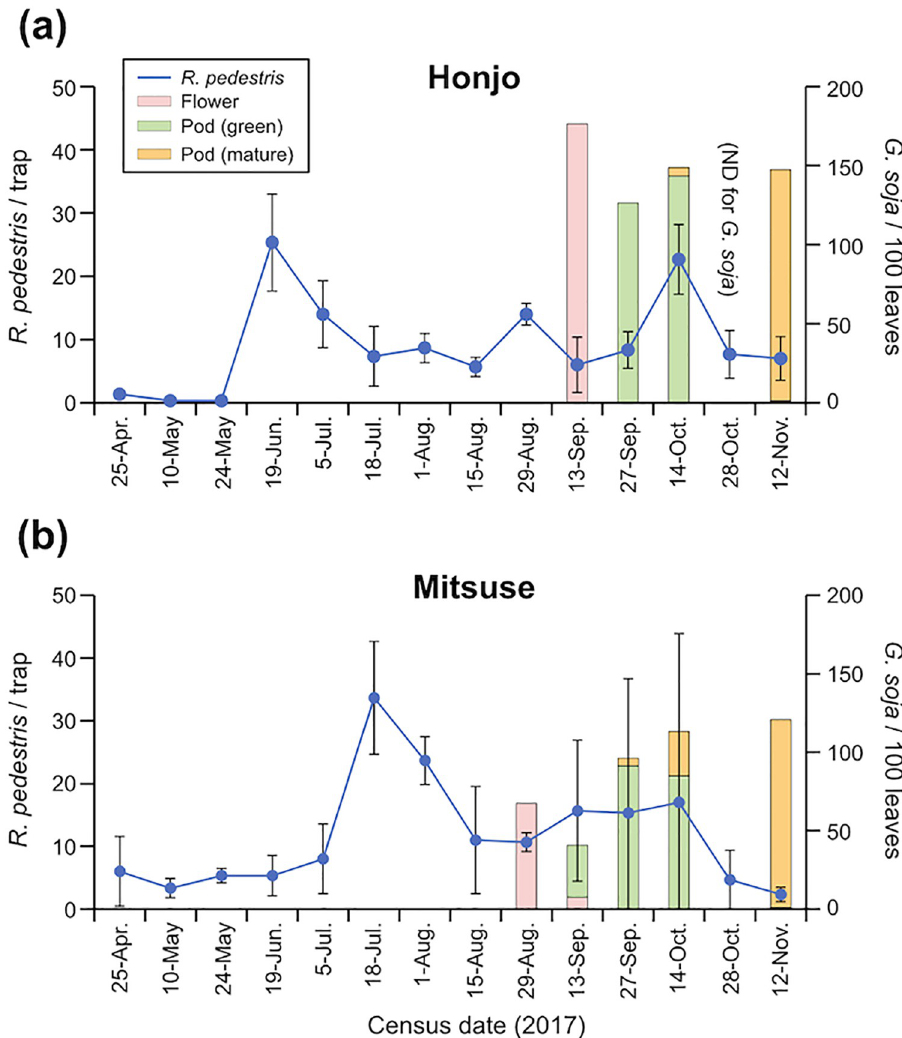
Fig 1. Seasonal trends (blue lines) of Riptortus pedestris captured by pheromone traps and pod maturation phenology of Glycine soja (bars) at the two census sites in Saga, northern Kyushu, Japan. Pink, green and yellow bars indicate the number of flowers, green pods and matured pods per 100 leaves,